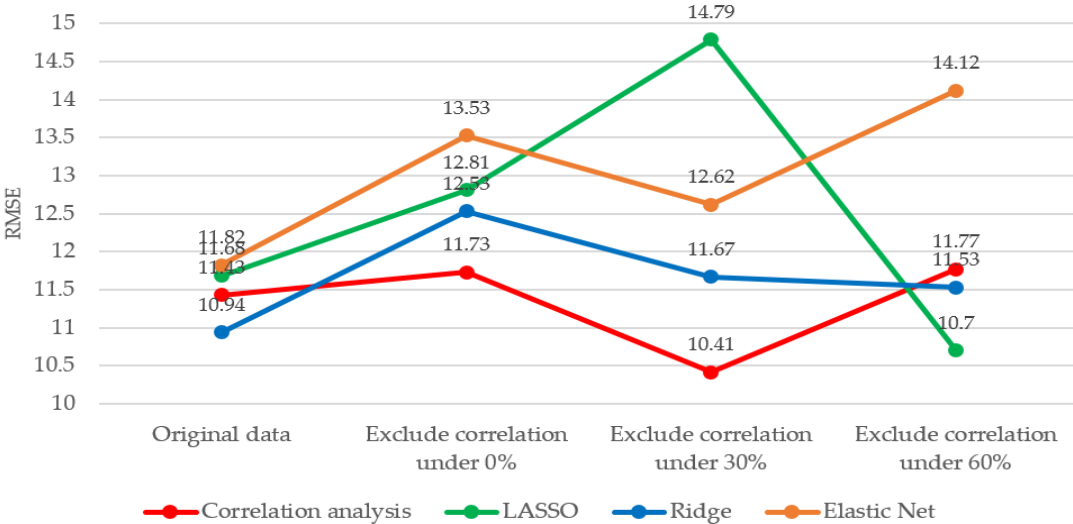
Figure 6. Comparison of RMSE for different feature selection methods.